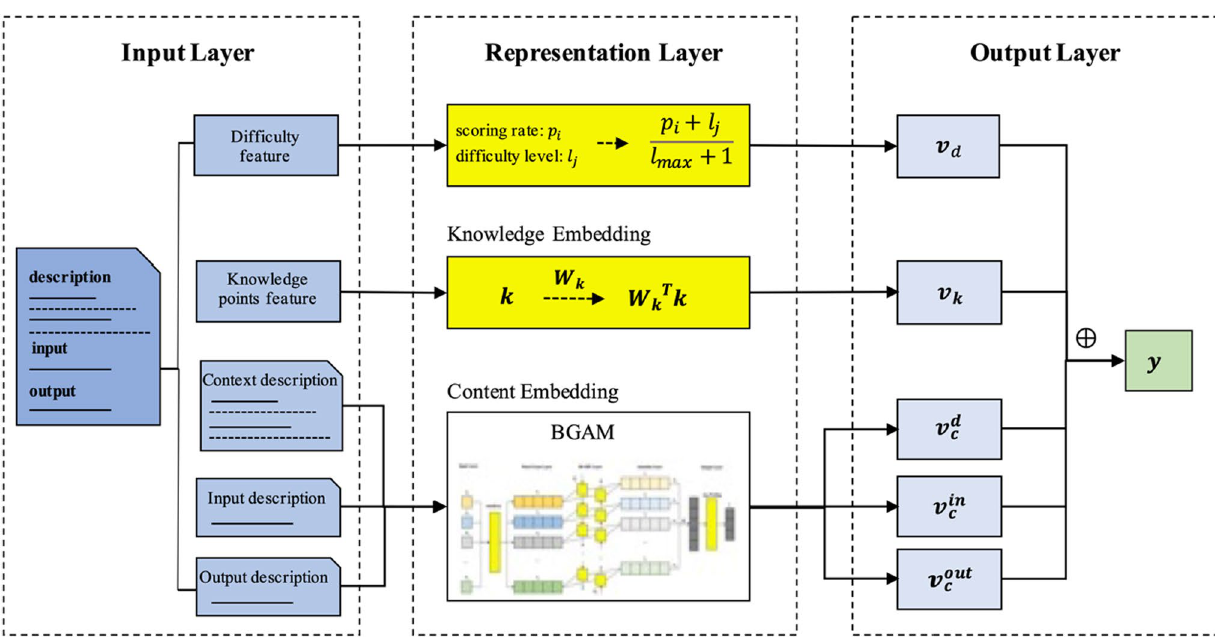
Fig. 2 MDPR: the structure of the multi-dimensional integrated programming problem representation